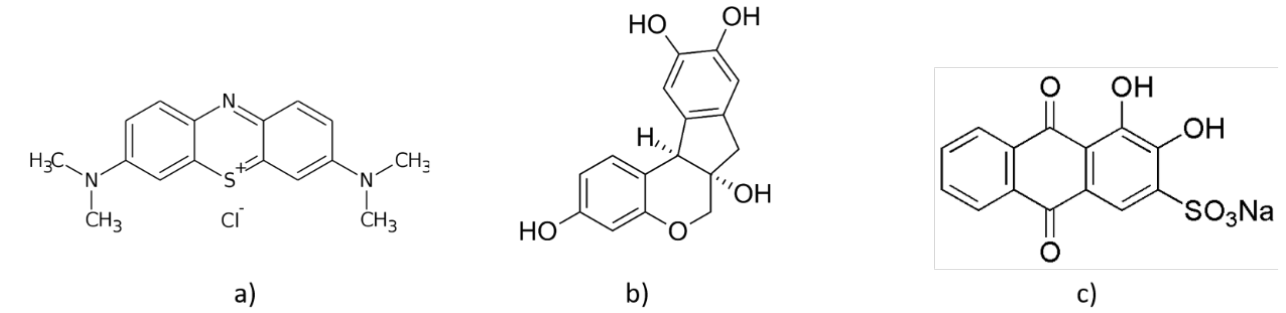
Figure 1. Molecular structure of the dyes: ( a ) methylene blue; ( b ) brazilwood; ( c ) alizarin red-S.